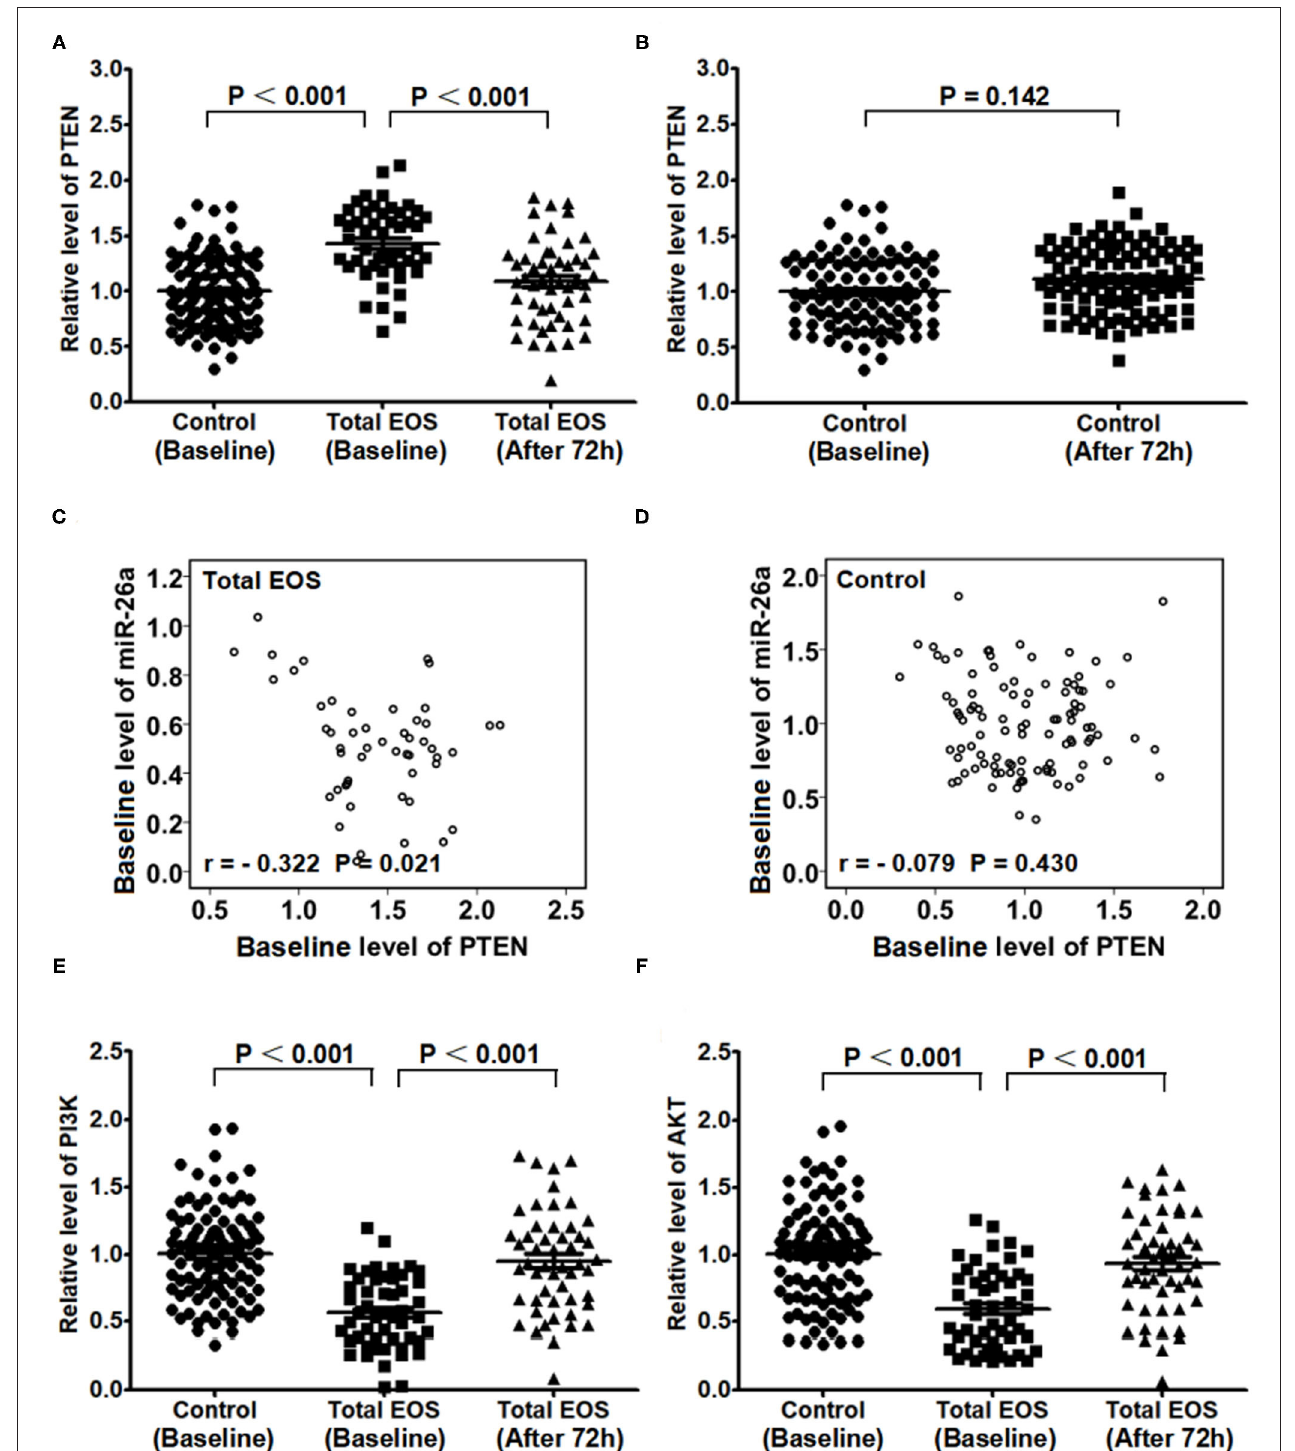
FIGURE 4 | Expression of PTEN/PI3K/AKT in peripheral blood mononuclear cells at baseline and 72 hours after birth. (A) Baseline expression of PTEN in the control and total EOS groups was compared. In (A,B) Expression of PTEN at baseline and after 72 hours was compared separately in the total EOS group and control group. In (C,D) Baseline association between miR-26a and PTEN was assessed separately in the total EOS group and control group. In (E,F) , baseline expression of PI3K and AKT was compared between the control group and total EOS group, and expression of the proteins at baseline and after 72 hours was compared in the total EOS group. Differences in continuous variables were detected using independent sample t-tests. The association of miR-26a with PTEN was detected using Pearson correlation analysis. “ P < 0.05” indicates a statistically significant difference. Total EOS, Newborns with clinical features of sepsis.